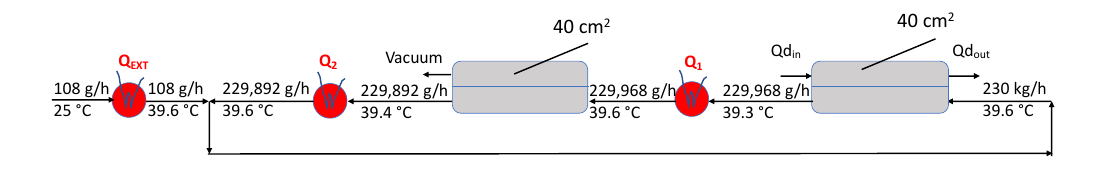
Figure 10. Integrated DCMD – VMD flowsheet.